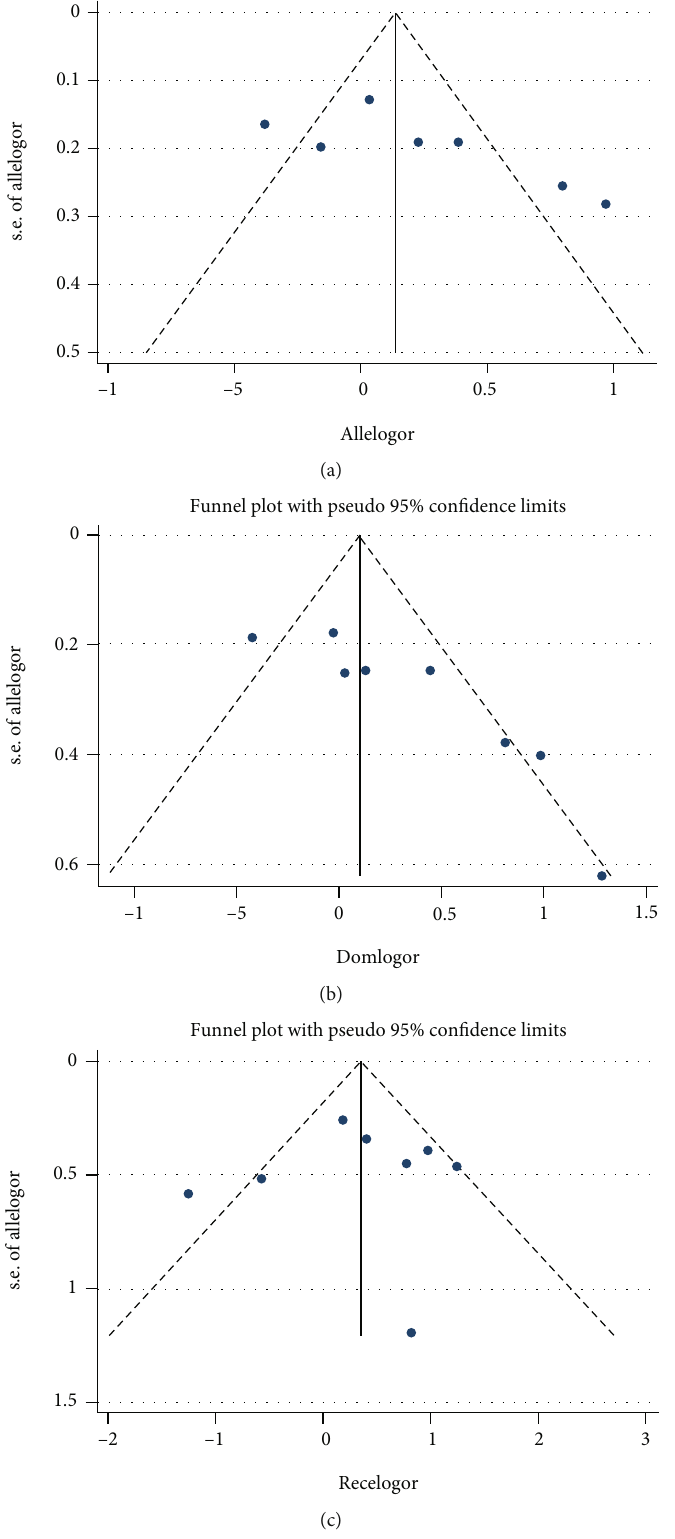
Funnel plot with pseudo 95% confidence limits